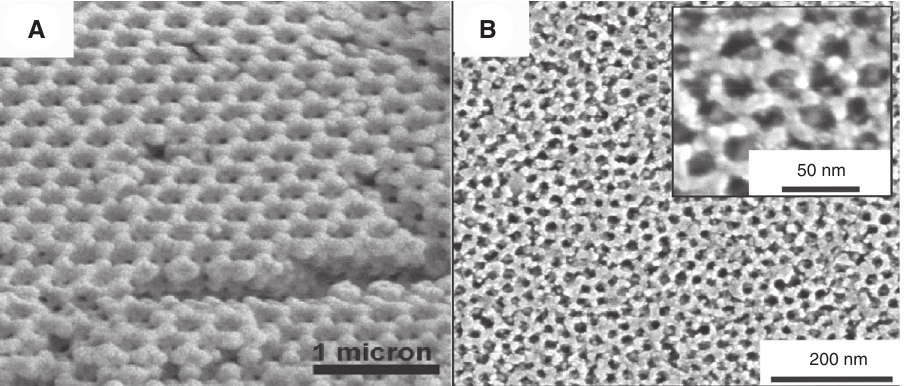
Ti O 3DOM architecture synthesized using poly(methylmethacrylate) colloidal crystal templates. Reprinted 4 5 12